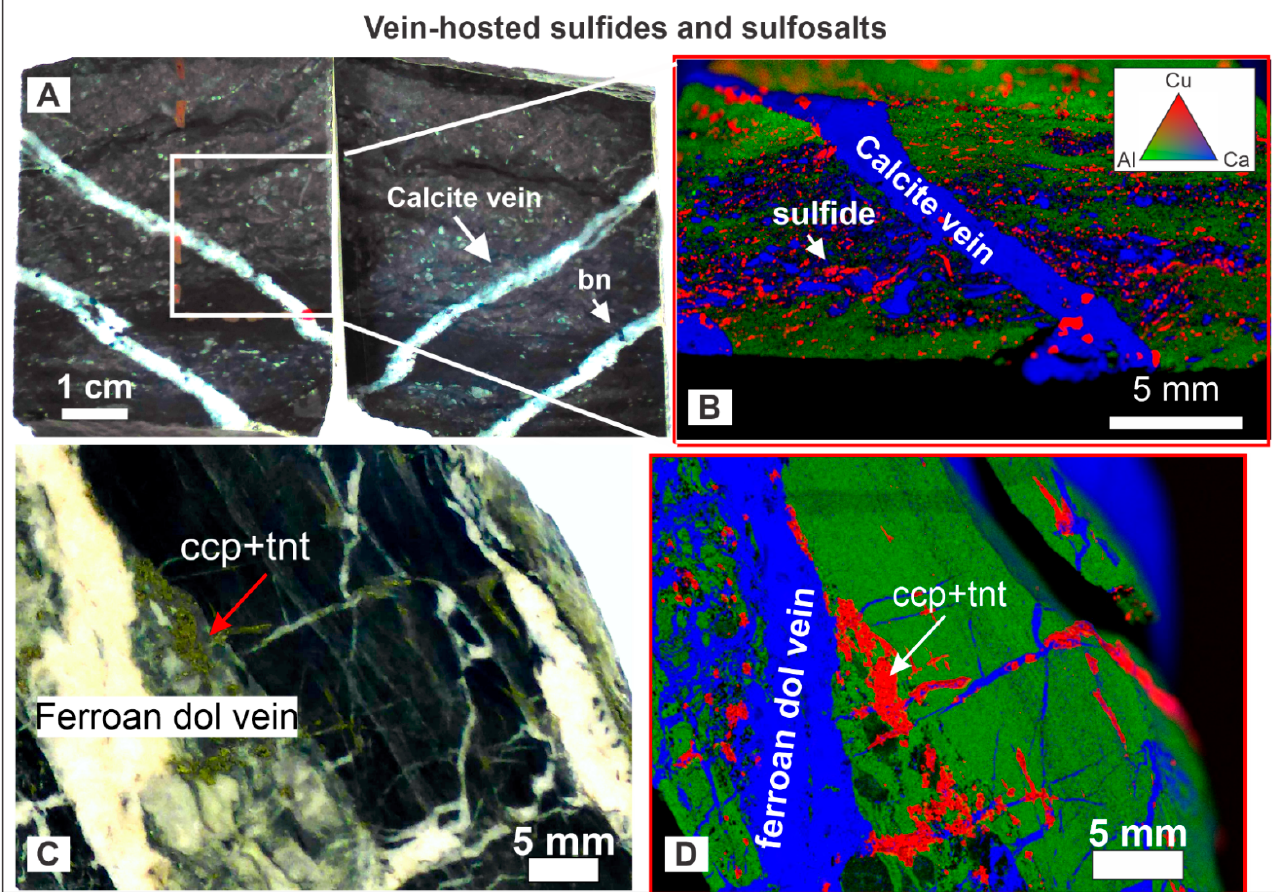
Figure 8. ( A , C ) Hand sample images and ( B , D ) Semi-quantitative chemical maps by µFRX analysis showing vein-hosted ore minerals.